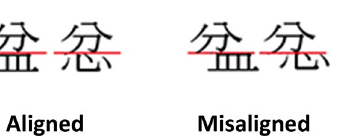
Figure 6. Example of the stimulus pairs in aligned and misaligned